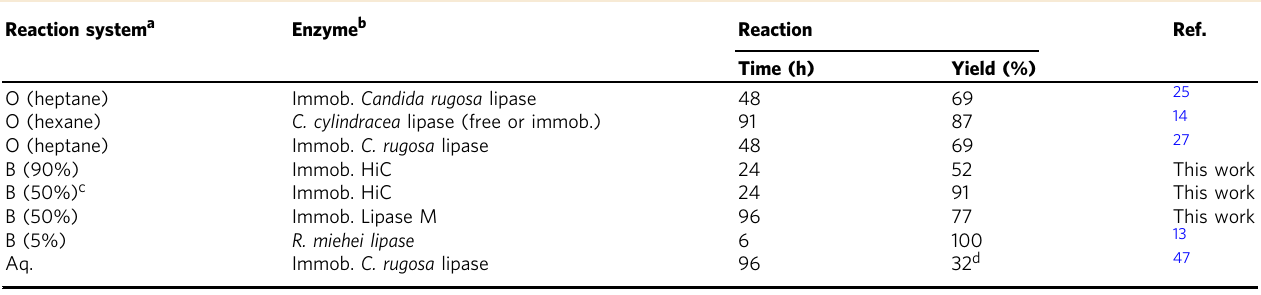
Table 1 Comparison of reaction conditions and yields of enzymatic butyl butyrate synthesis Reaction system a Enzyme b Reaction Ref. Time (h) Yield (%) Immob. Candida rugosa lipase